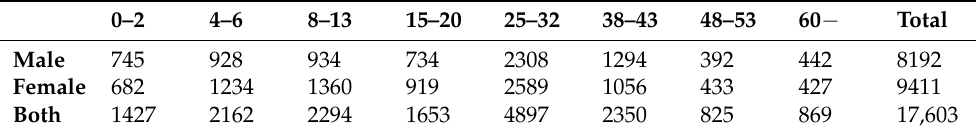
Table 1. Adience faces